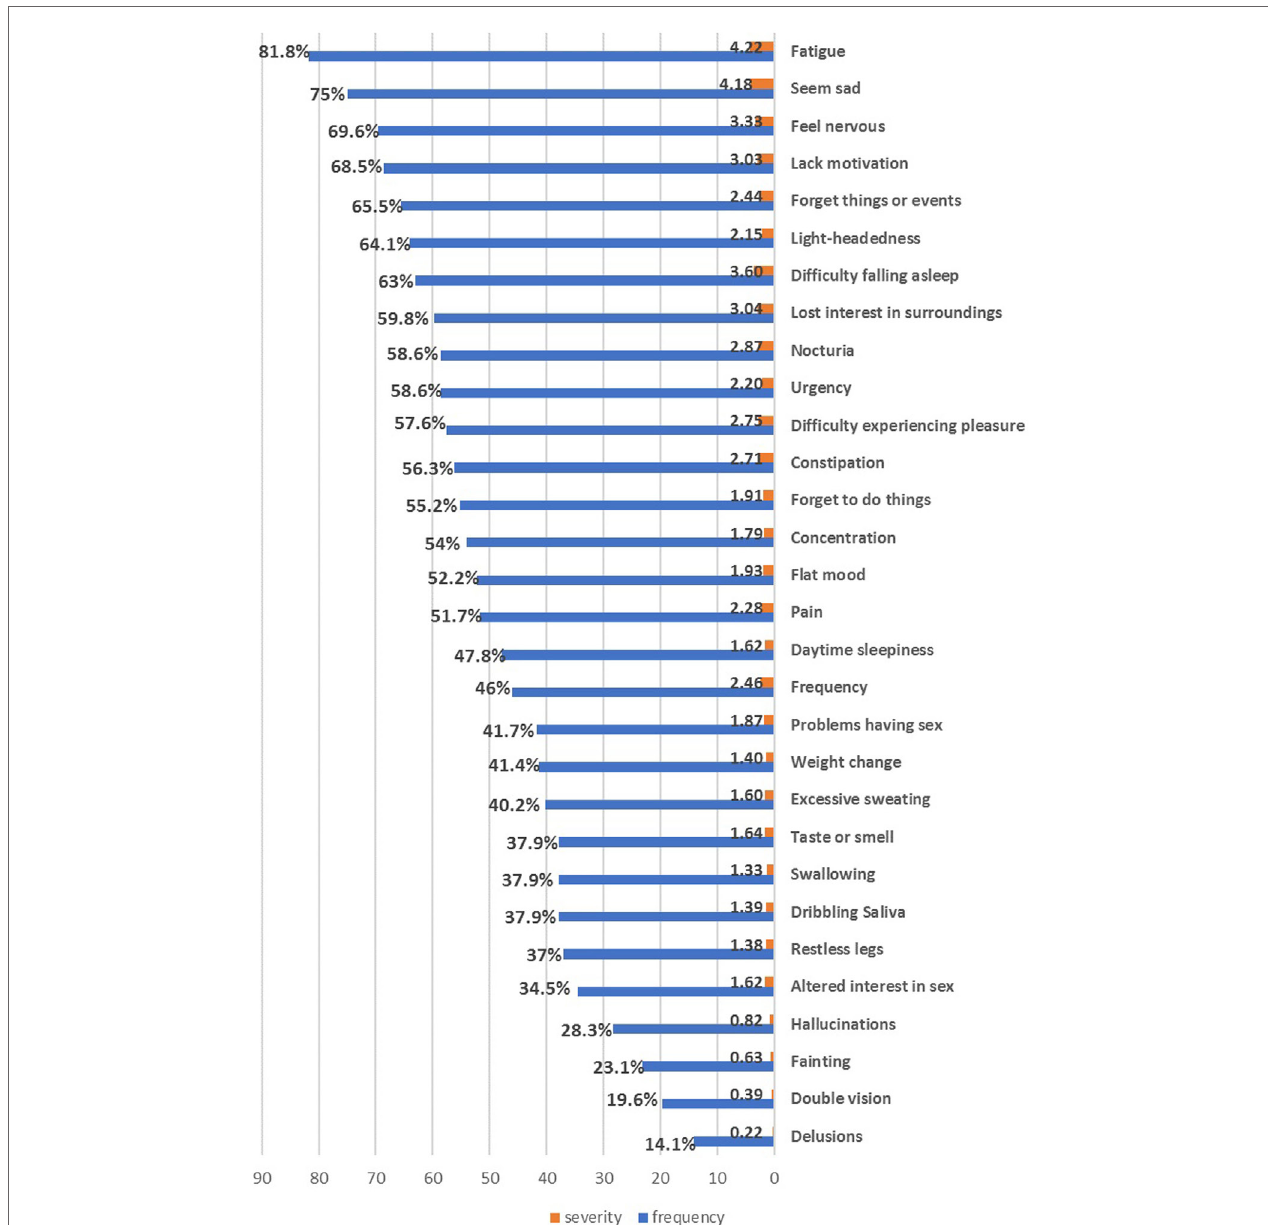
FigUre 1 | The frequency and severity of individual non-motor symptoms in the enrolled Parkinson’s disease